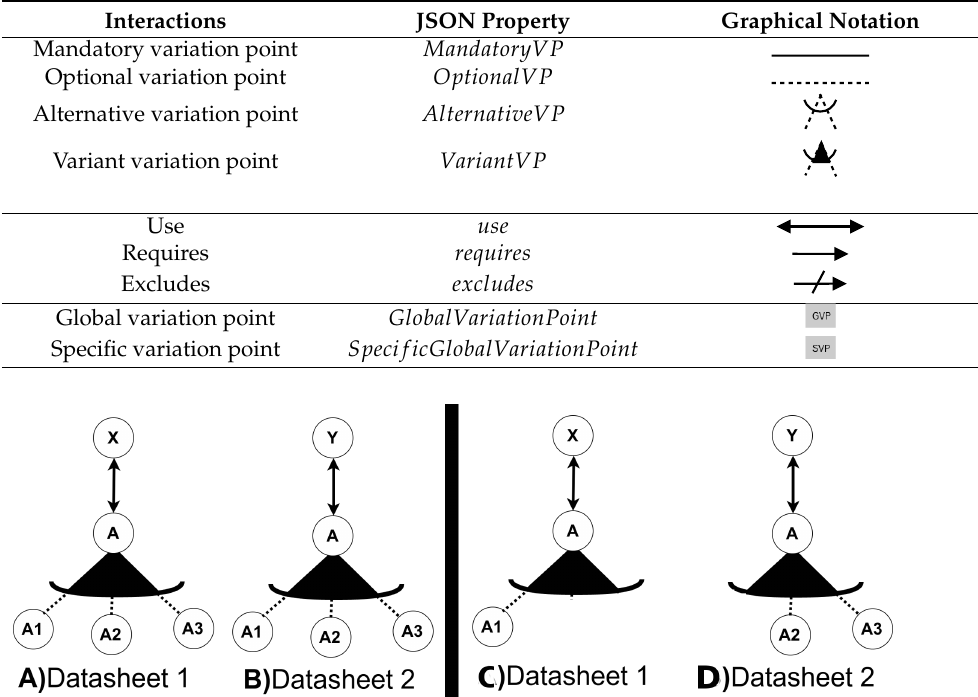
Figure 4. An example of the use of scope operators in two datasheets.